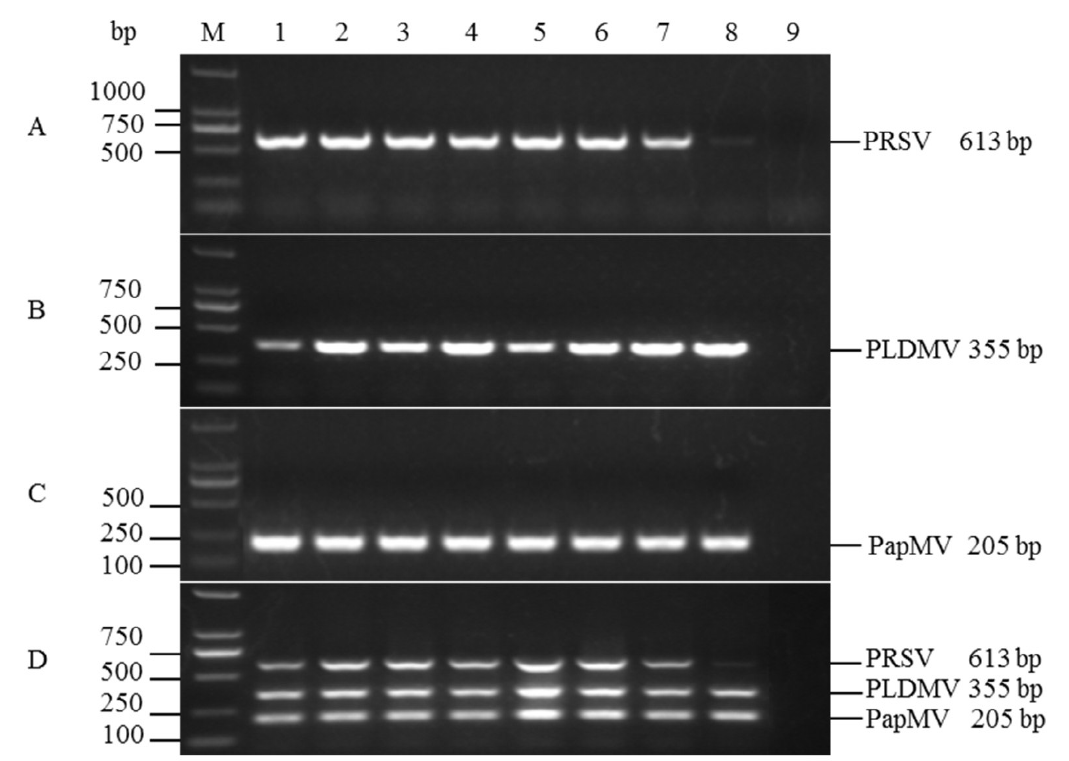
Figure 2. Optimization of the annealing temperature for uniplex RT-PCR of ( A ) PRSV (613 bp); ( B ) PLDMV (355 bp); and ( C ) PapMV (205 bp) and ( D ) multiplex RT-PCR assay. ( A )–( C ), uniplex RT-PCR; ( D ), multiplex RT-PCR. Lane M: DL2000 DNA Marker; 1: 50 °C; 2: 51.7 °C; 3: 53.6 °C; 4: 55.8 °C; 5: 57.9 °C; 6: 60.1 °C; 7: 62.2 °C; 8: 64.3 °C; 9: negative control (ddH 2 O).